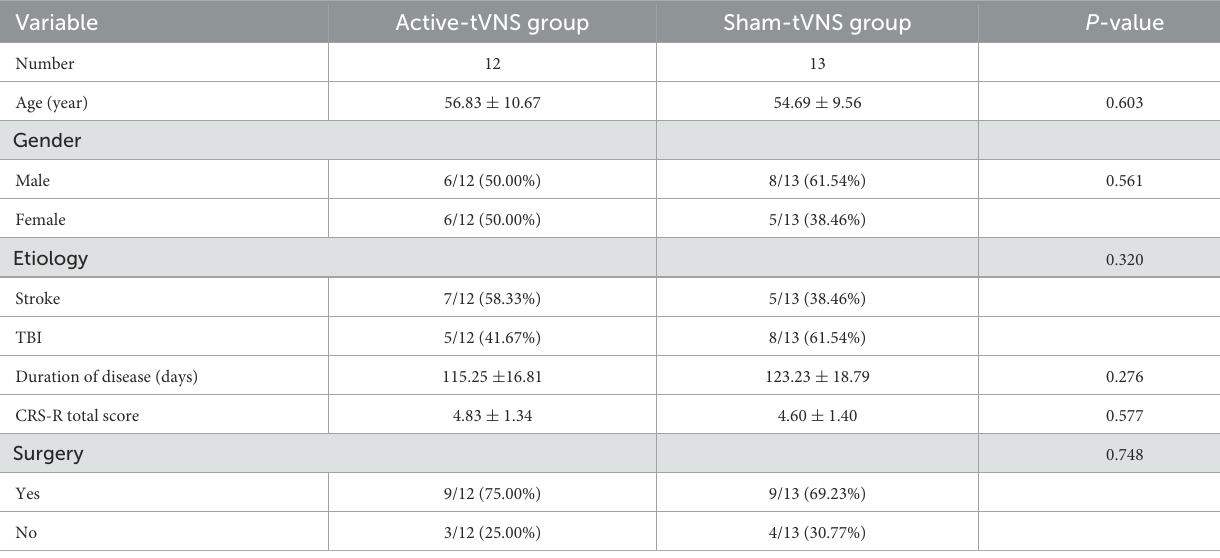
TABLE 4 Baseline demographic and clinical comparisons of VS/UWS subjects undergoing active or sham